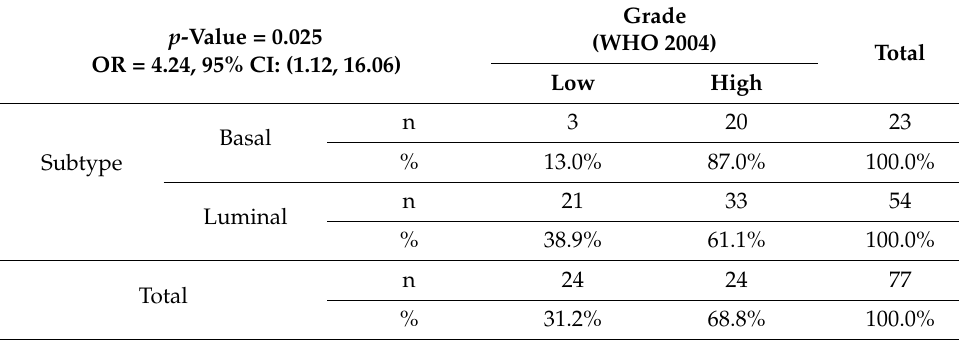
Table 3. Association of BC molecular subtype with Grade. p -Value =